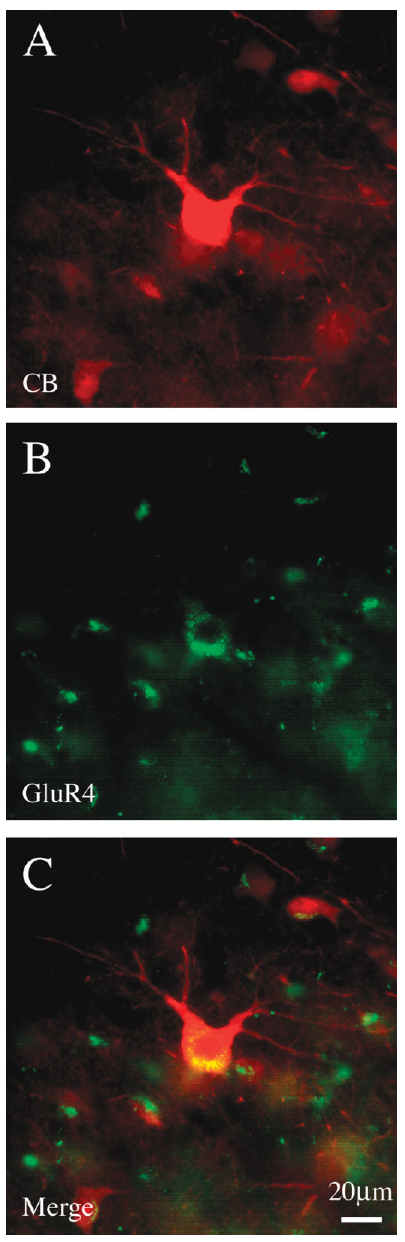
Figure 7. Giant CB + neurons are co-labeled by GluR4 . ( A ) Giant CB + neuron.( B )Samesection,reactedforGluR4.( C )Mergedimagedirectlydemon- strates co-labeling of CB and GluR4. (Small cells are glia, which are positive for